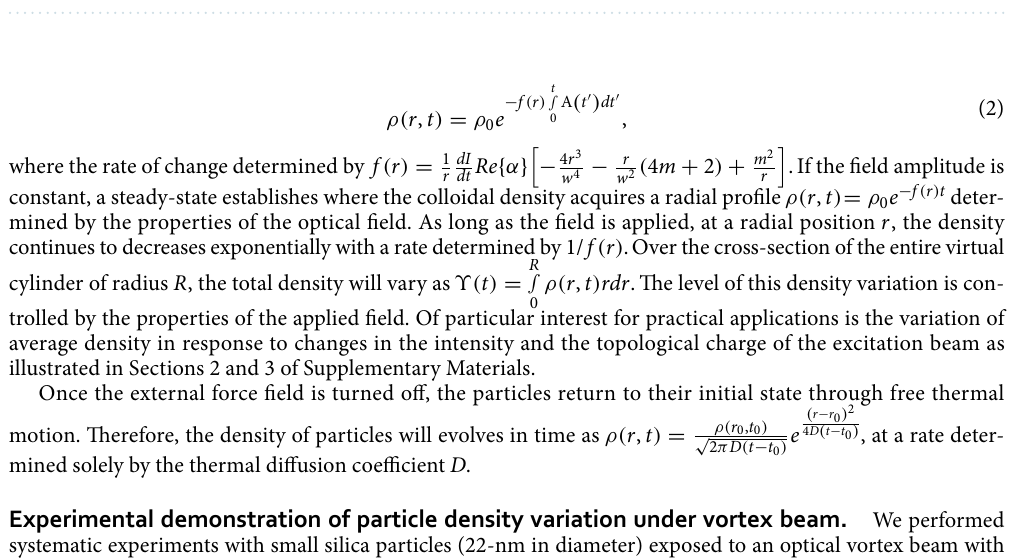
Figure 3. Normalized values of transmitted intensity during 1200 s of vortex field exposure. The green vortex field is off for the first and the last 150 s of each cycle. The inset shows the transmittance of the same sample during four exposure